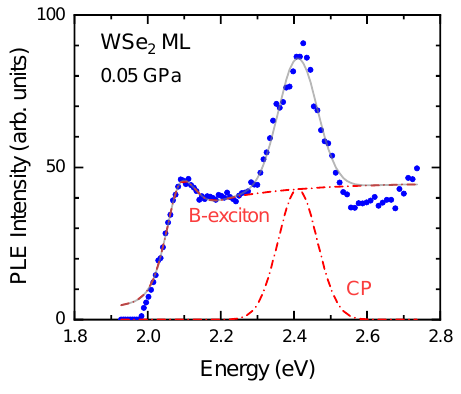
Figure 3: PLE spectrum (closed blue symbols) of the bare WSe 2 ML at a very low pressure right after closing the DAC. The solid grey curve and the dash-dotted red curves represent the lineshape fitting function and its components, respectively, associated to the B-exciton and a critical point